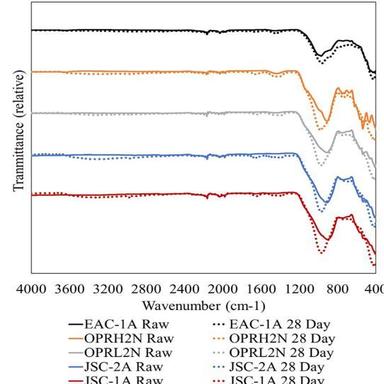
The FTIR spectra comparing the raw lunar regolith simulant to the 28-day geopolymer spectra (legend order from top to bottom matches pattern order).